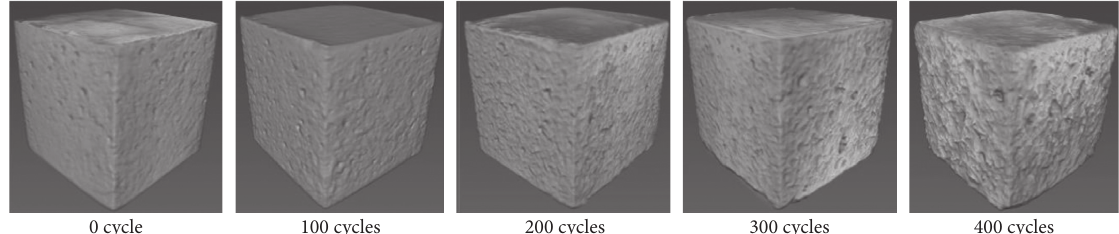
Figure 12: Profile of 8% CaO expansive concrete (C-8) under different freeze-thaw